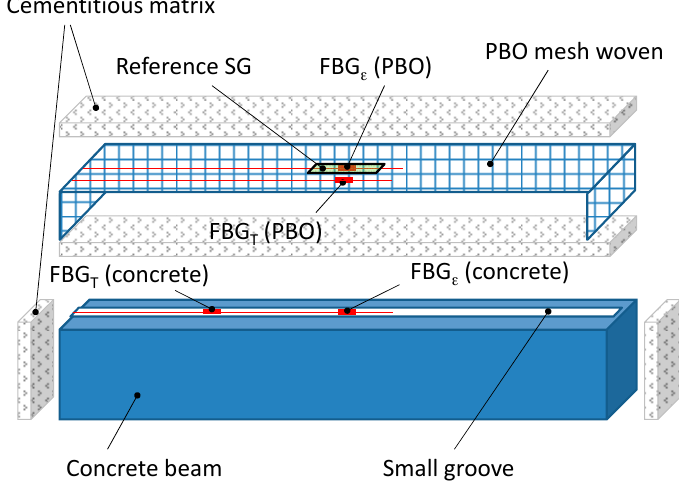
Figure 2. Schematic drawing of instrumented FRCM strengthened beam with embedded FBGs. (not in scale).